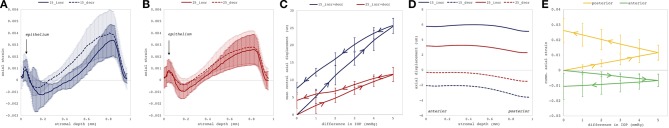
Deformation analyses in the central cornea region. Mean axial strain profiles (N = 6 eyes) along corneal thickness in response to a 1-mmHg change in intraocular pressure (IOP), with (A) 15 and (B) 25 mmHg initial IOP. The largest compressive strains were observed in the posterior stroma. Error bars represent the standard deviation across the six eyes. (C) Induced suprapixel bulk displacement of the whole cornea, accumulated for the entire IOP modulation cycle. Error bars represent the standard deviation across the six eyes. (D) Combined axial displacement profile consisting of integrated axial gradient and suprapixel displacement for a single 1-mmHg IOP step. (E) Cumulative corneal strain in the anterior and posterior corneas as a function of IOP with initial IOP of 15 mmHg. Here, anterior cornea was defined as the region experiencing negative strains and posterior cornea as the region experiencing positive strains. _incr: IOP increase, _decr: IOP decrease, 15: 15 mmHg initial IOP, 25: 25 mmHg initial IOP. Error bars are omitted for clarity.